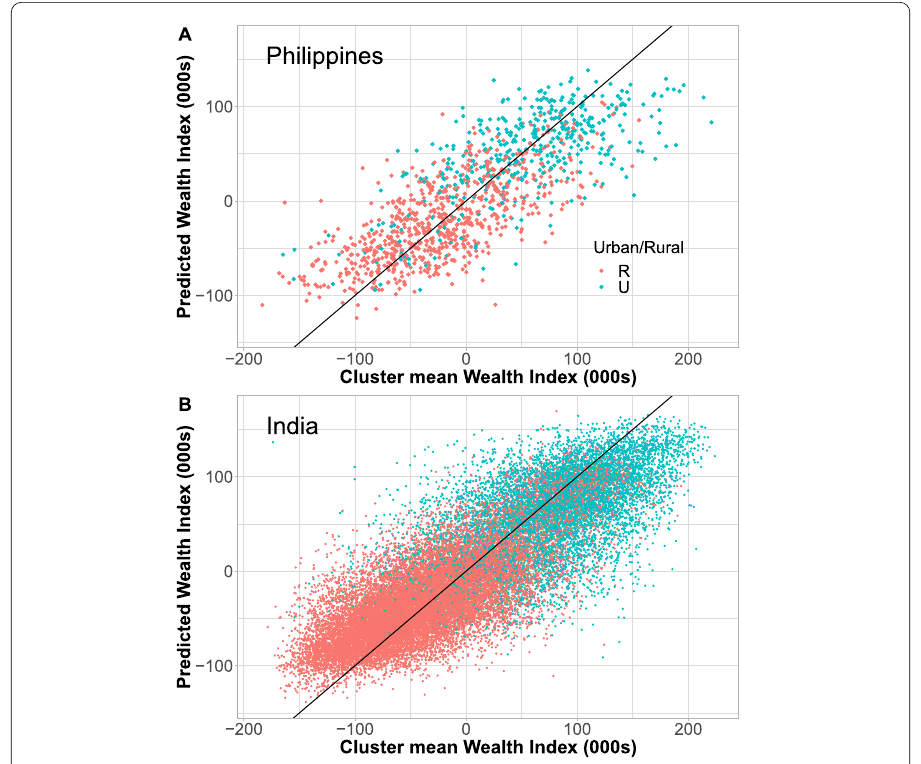
Figure 1 Scatter plot of DHS Wealth Index against predictions. Scatter plot of ground truth Wealth Index from the DHS against the predictions from the 10-fold cross-validation for ( A ) Philippines (1205 DHS clusters) and ( B ) India (28,043 DHS clusters); all values are in thousands. Plotted line is the diagonal. Predictions are for the regression tree models with Facebook features, log population density and regional indicator variables for each